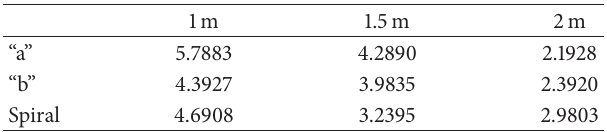
Table 2: Average error of tracking with various distance conditions (UNIT: